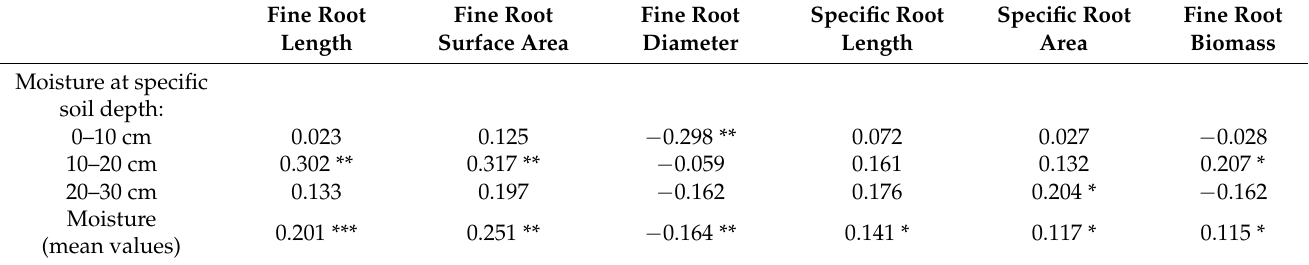
Table 3. Correlation analysis results of the relationships between root traits and soil